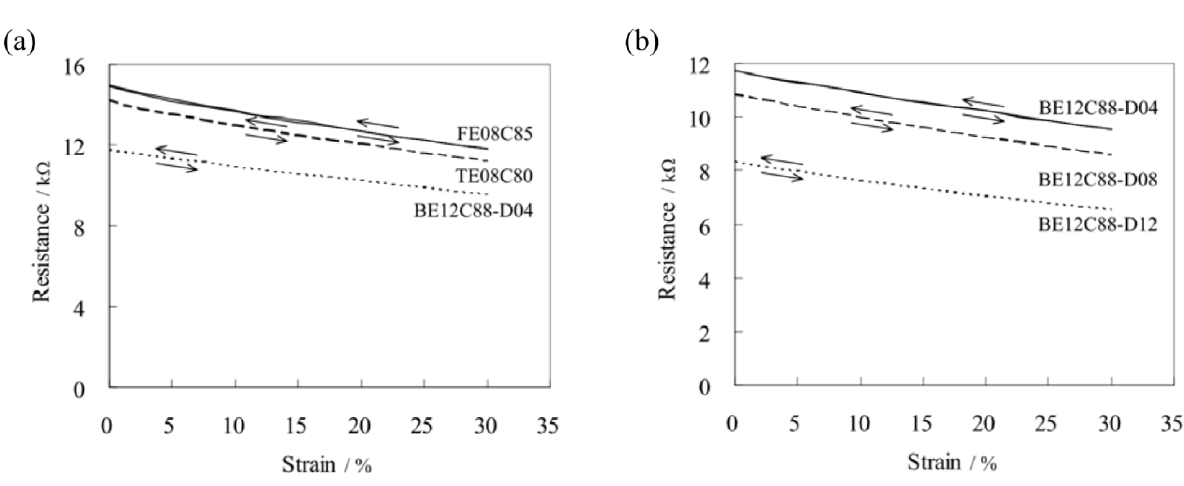
(a) varied webbing structures and (b) weft yarn density in the belt